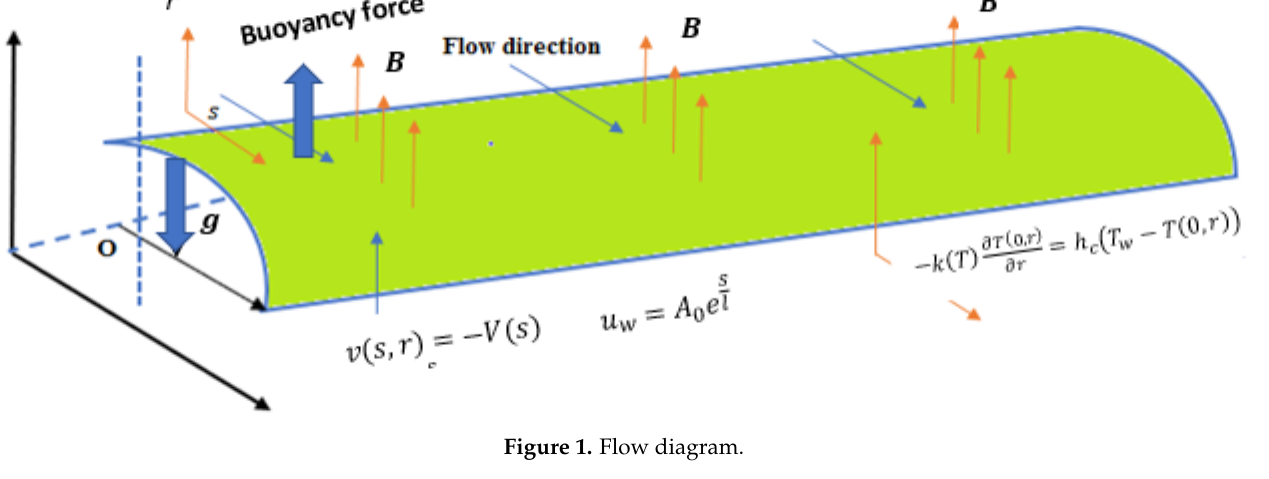
Figure 1. Flow diagram.